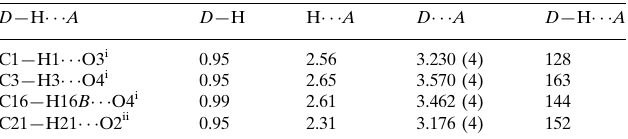
Hydrogen-bond geometry (A˚ , (cid:2)